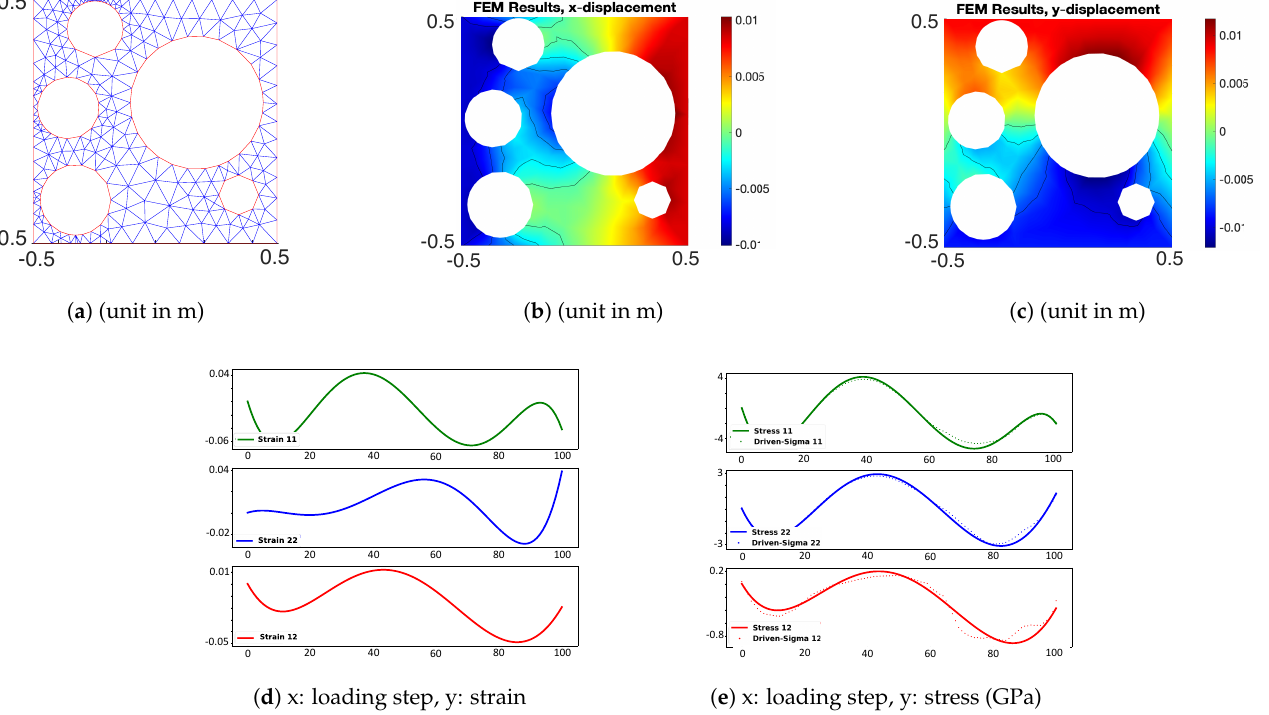
Figure 8. Test 2 for homogenization of linear elastic microstructure ( µ = 25 GPa and λ = 200 GPa), ( a ) FEM mesh, ( b ) X displacement (initial step), ( c ) Y displacement (initial step), ( d ) random generated strain, and ( e ) comparison of homogenized effective stress and data-driven